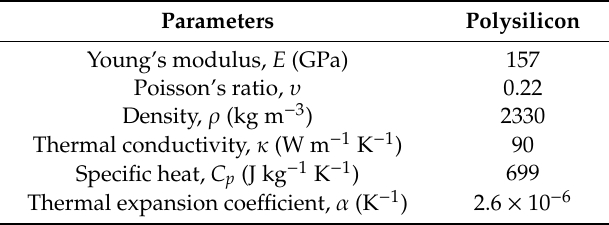
Table 3. The first seven natural frequencies of the bionic model.